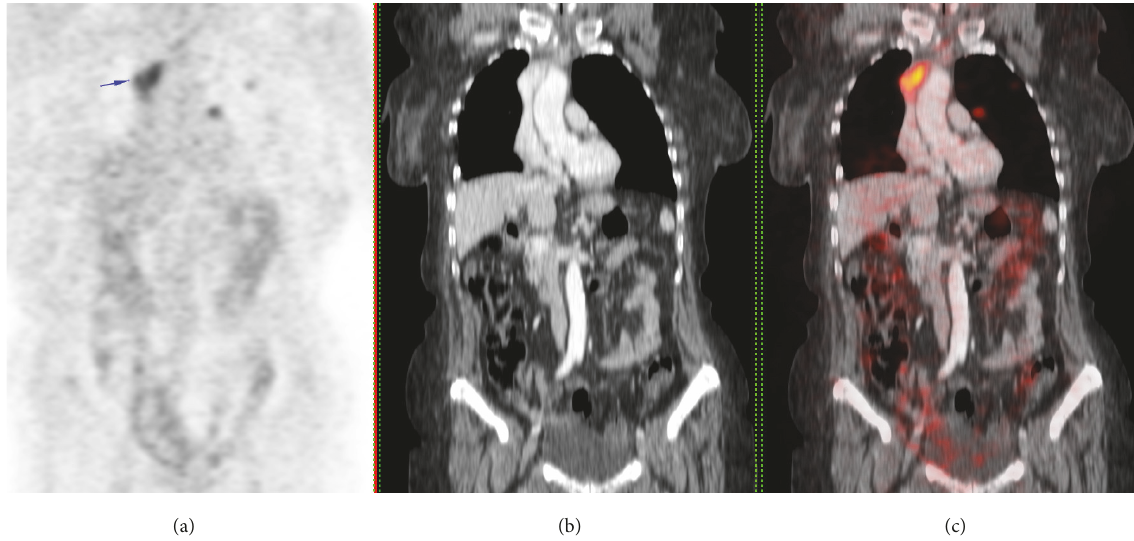
Figure 1: (a) An uptake in the 18F-fluoro-D-glucose PET and (b) small depletion defect in the innominate vein growing towards the superior cava vein, and when we did the fusion with CT scan, (c) intravascular metastasis was